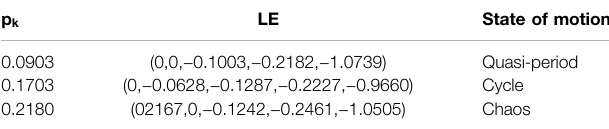
TABLE 4 | LE and system status at different p k values.